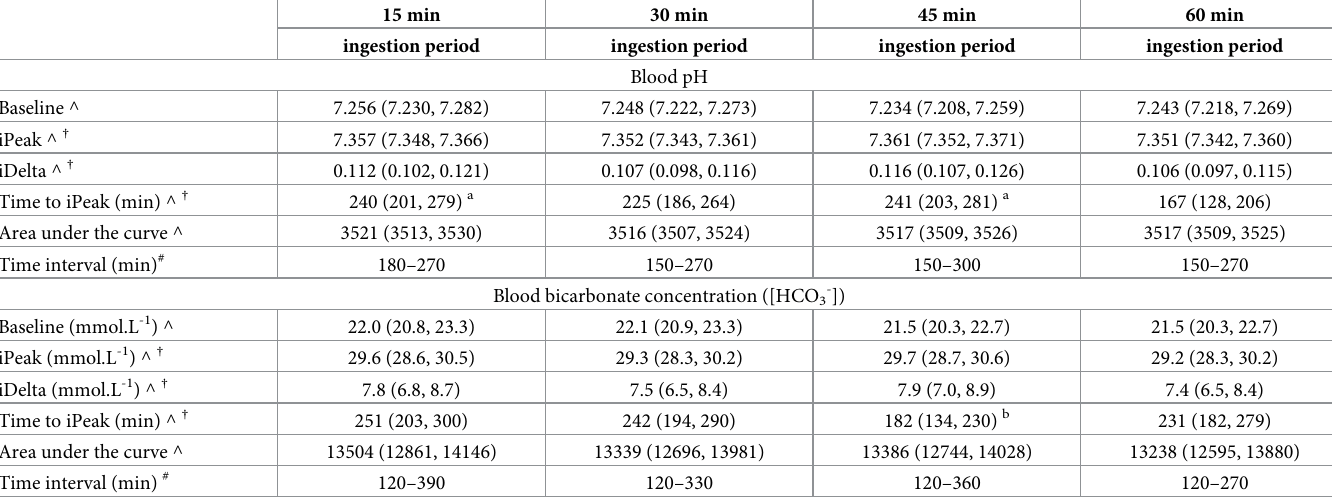
Table 2. Estimates of curve characteristics for blood pH and blood bicarbonate concentration ([HCO 3- ]) following ingestion of 500 mg.kg -1 BM sodium citrate over 15, 30, 45 or 60 min ( n = 16 participants per